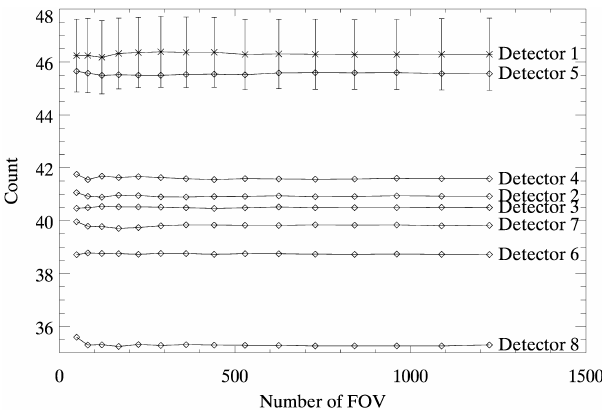
Figure 4. Variation of average and standard deviation of space-look signal in terms of the digital count value as a function of number of pixels used to estimate the average and standard deviation.